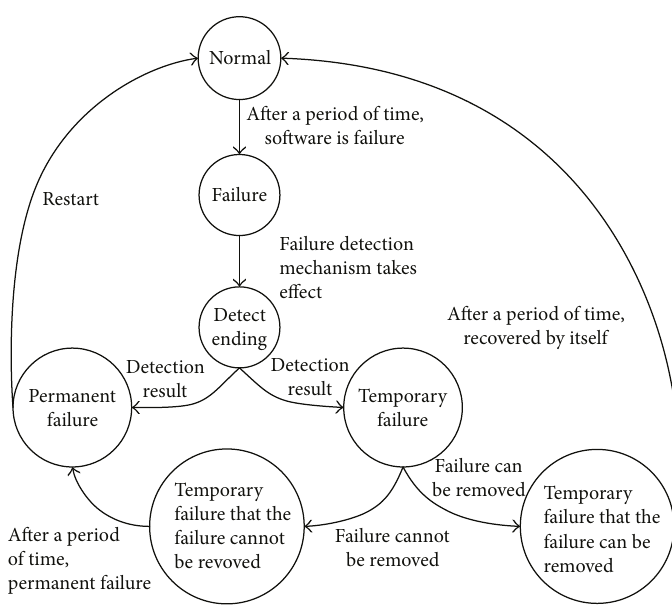
Figure 2: Single hardware error model.